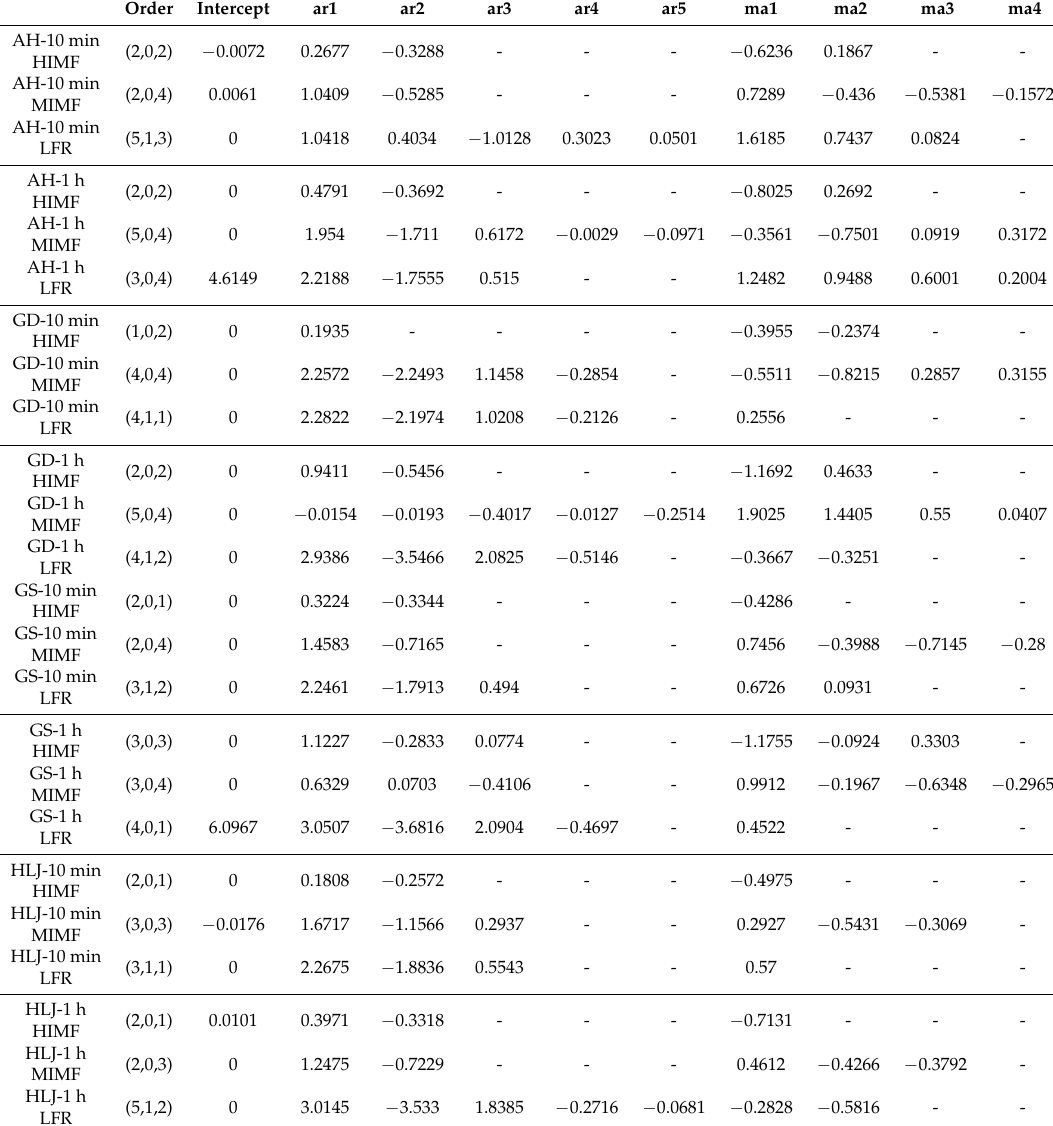
Table 9. EMD-ARIMA model parameters of various wind speed